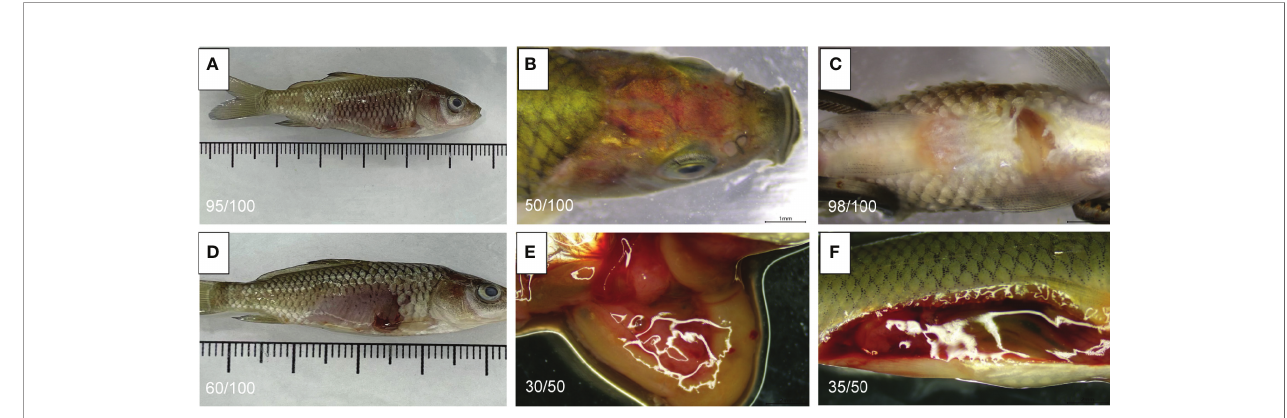
FIGURE 1 | Symptoms of infected C carpio . (A) The abdominal scales of infected C carpio fell off, and the abdomen was red and swollen. (B) Red head of infected C carpio . (C) Swollen abdomen of infected C carpio . (D) The abdominal scales of infected C carpio fell off. The abdomen became red, with abscess-like fl uid fl owing out of it. (E) The visceral tissue was diffuse, and the liver was enlarged and pale. (F) The abdominal cavity of C carpio had a lot of yellowish fl uid after